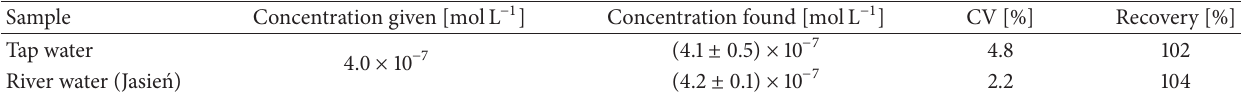
Table 3: Results of NT determination in spiked samples with SWAdSV.